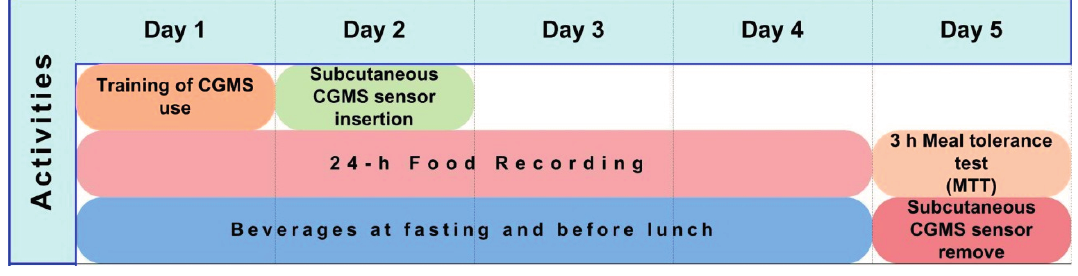
Figure 1. Study Protocol for all